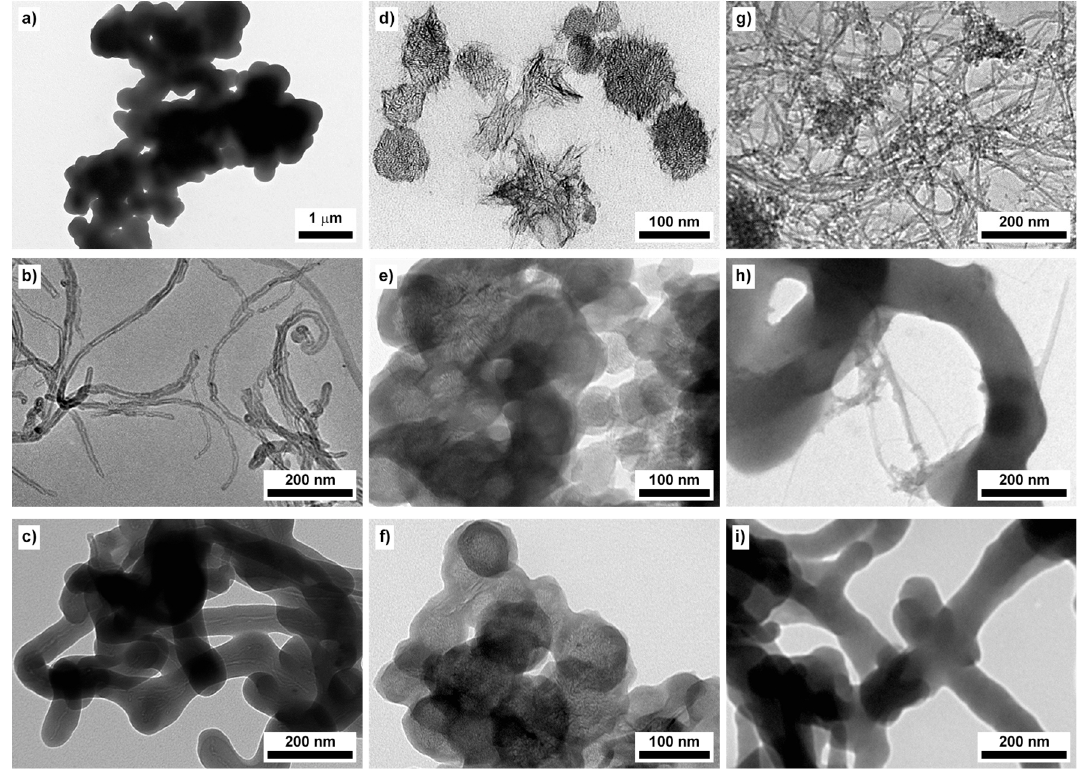
Figure 2. TEM images of: ( a ) homopolymer HP, ( b ) pristine MWCNTs, ( c ) MW-1:12, ( d ) pristine CNHs, ( e ) NH-1:4, ( f ) NH-1:12, ( g ) pristine SWCNTs, ( h ) SW-1:2, ( i ) SW-1:4.